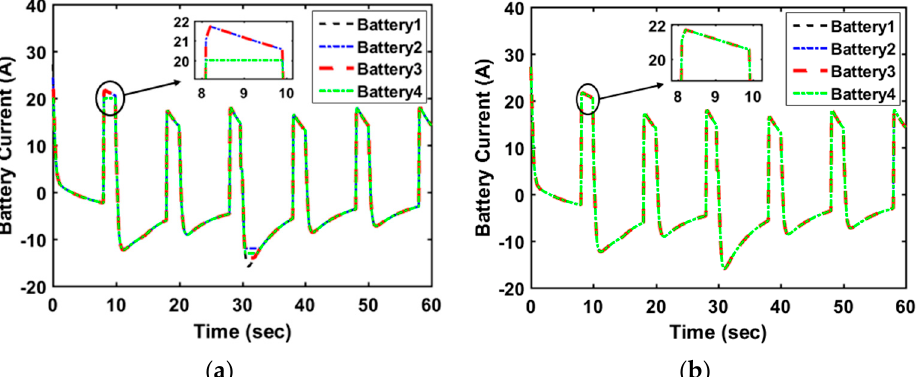
Figure 16. Current profile for individual batteries ( a ) without and ( b ) with the proposed method.